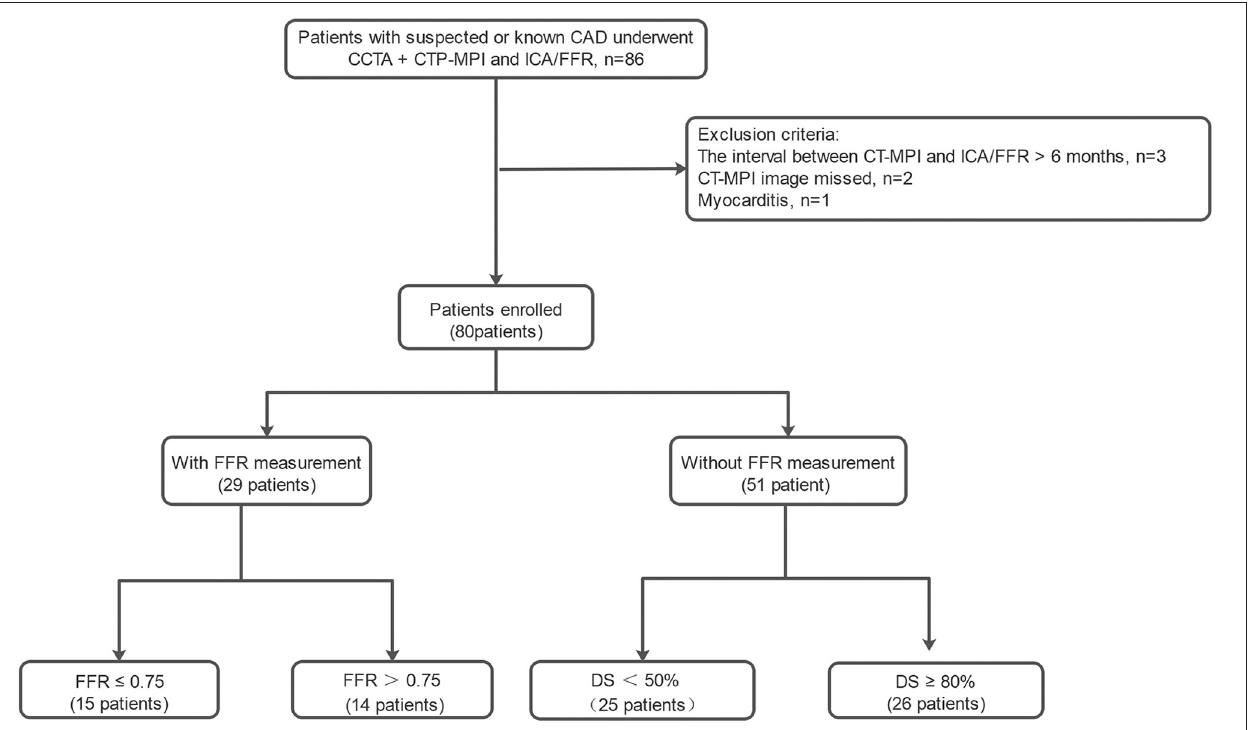
FIGURE 1 | Study flowchart of inclusion and exclusion for the patients. CCTA, coronary computed tomography angiography; CT-MPI, computed tomography myocardial perfusion imaging; DS, diameter stenosis; FFR, fractional flow reserve; ICA, invasive coronary